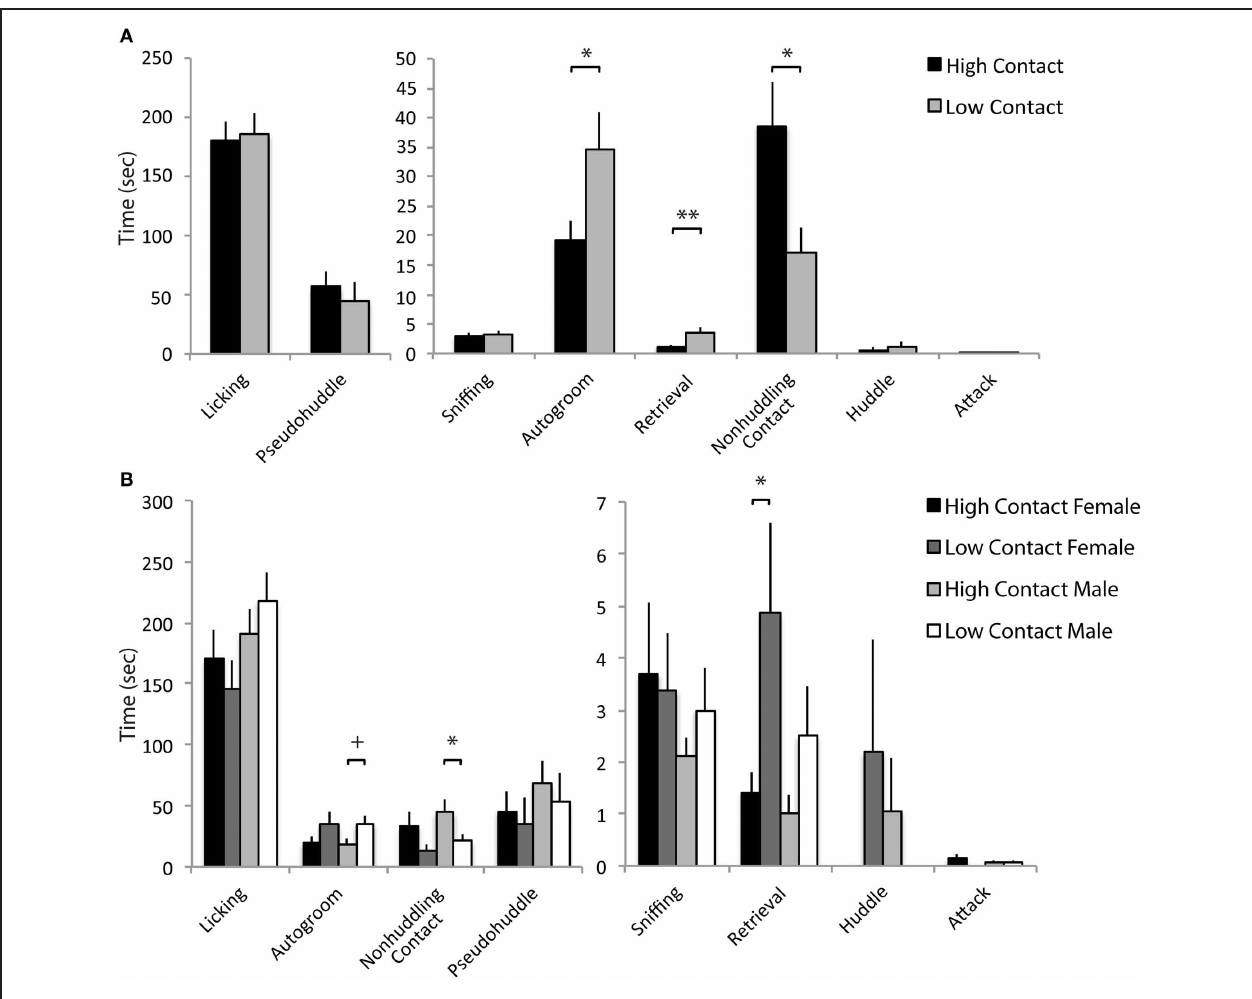
FIGURE 5 | Alloparental care data. (A) High-contact offspring spent more time in non-huddling contact with pups [ F ( 1 , 66 ) = 5 . 31, p = 0 . 02]. Low-contact offspring spent more time autogrooming [ F ( 1 , 66 ) = 5 . 21, p = 0 . 02] and retrieved pups more [ F ( 1 , 66 ) = 6 . 59, p = 0 . 01]. (B) High-contact